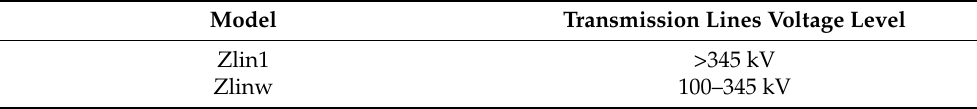
Table 3. The voltage level of the lines modeled with Zlin1 and Zlinw